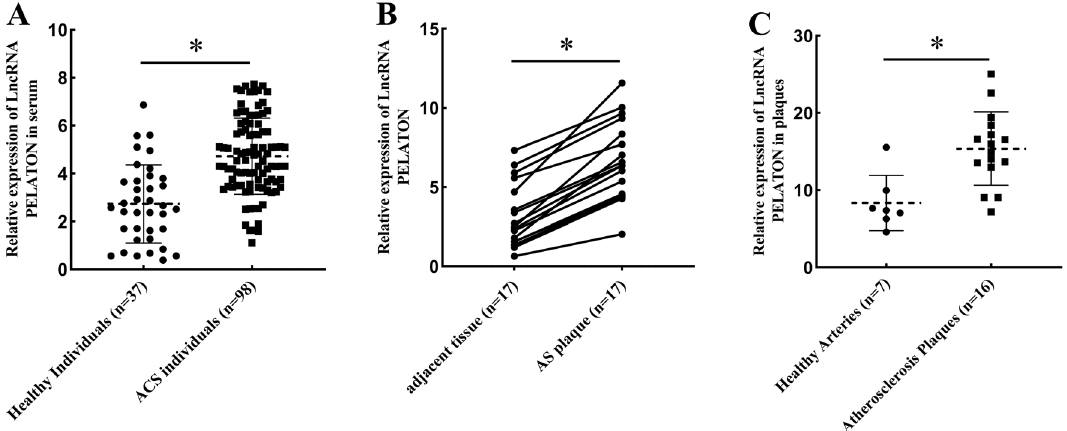
Figure 1. Expression of lncRNA PELATON in ACS. ( A ) Level of lncRNA PELATON in patients with ACS and healthy individuals. ( B ) Level of lncRNA PELATON in atherosclerotic plaques and adjacent tissue in the coronary artery. ( C ) Level of lncRNA PELATON in atherosclerotic plaques and healthy arteries in the carotid artery. * indicates p <